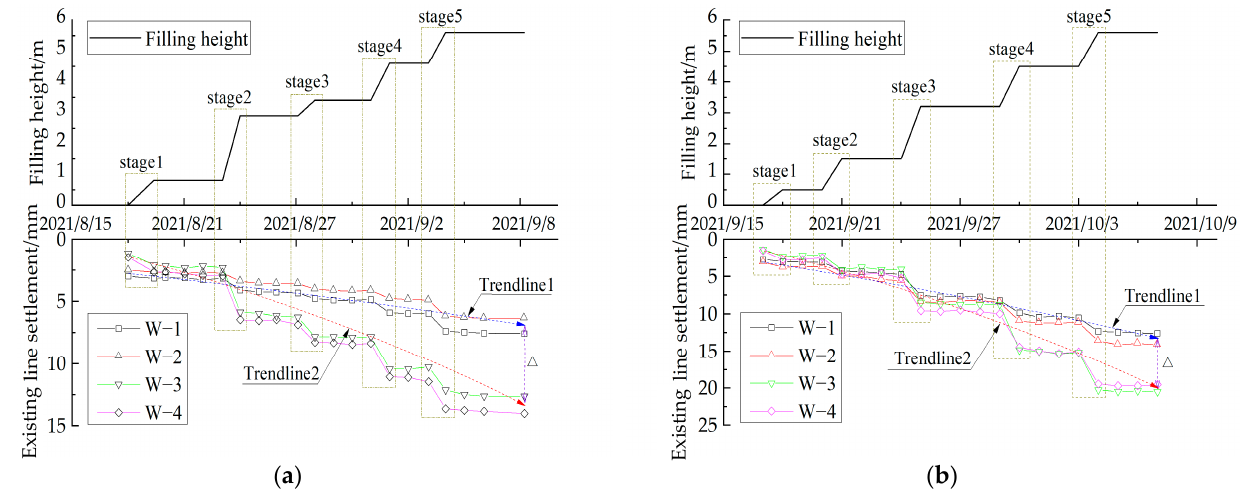
Figure 13. Relation curve of the level gauge settlement-filling-time: ( a ) Site1; ( b ) Site 2.